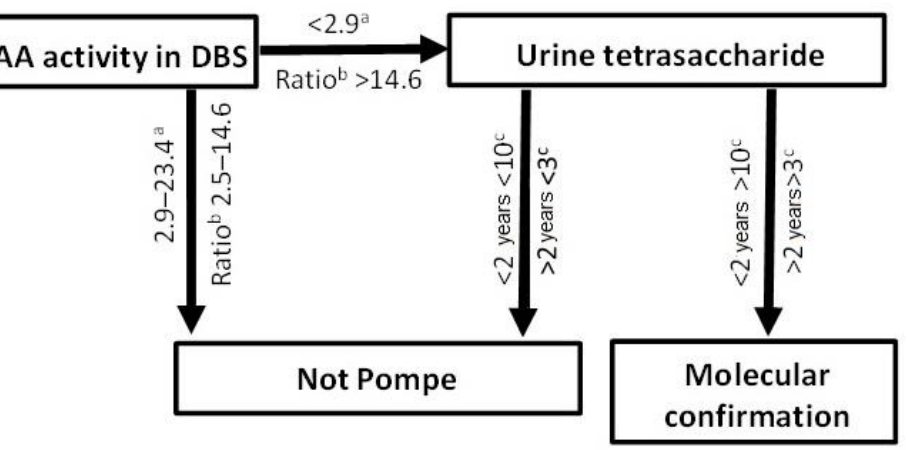
Figure 5. Laboratory diagnostic pathway for Pompe disease. a pmol/spot/h; b ratio of total α - glucosidase/GAA; c mmol/mol